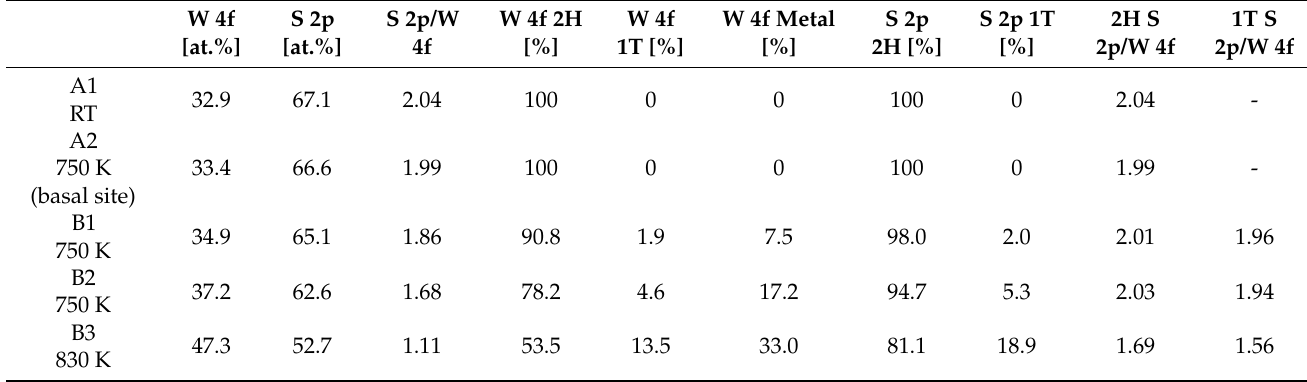
Figure 2. W 4f ( a ) and S 2p ( b ) SPEM maps recorded at room temperature (RT) in the binding energy (BE) range of 29.3– 37.0 eV and 158.5–166.2 eV, respectively. W 4f ( c ) and S 2p ( d ) single energy distribution curve of microspot photoemission ( μ‐ PE) spectra acquired at A1 point. Table 1. Relevant quantitative µ -PE data in different spots of the flakes (see Figures 2 and 3). The data have been derived from the chemically shifted components of W and S after deconvolution of the core level spectra.